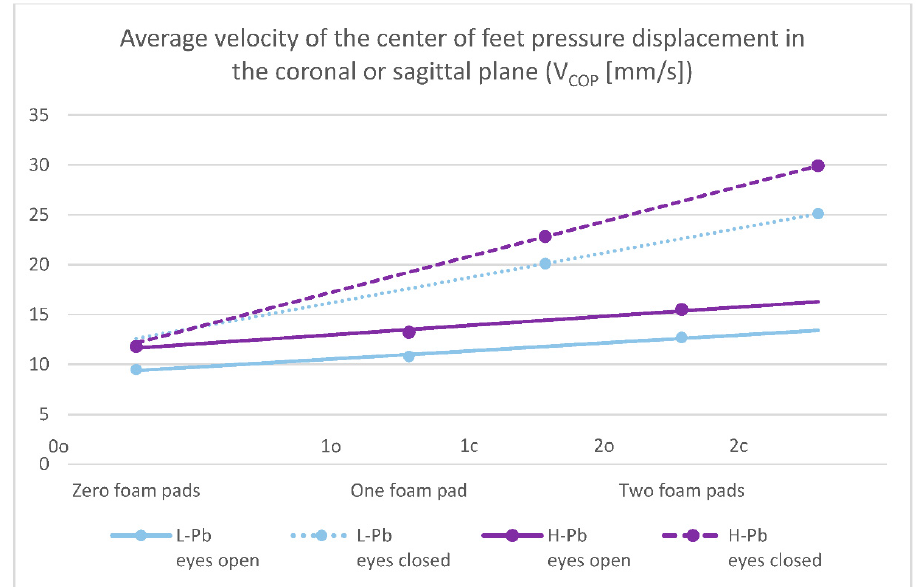
Figure 2. Posturography test results: average velocity of the center of feet pressure displacement in the coronal or sagittal plane—V COP (mm/s). L-Pb—low-PbB-level subgroup, H-Pb—high-PbB-level subgroup. Posturographic parameters are described in Table 7. A trend line has been marked. Calculations based on the values in Table 3. The graph shows only statistically significant results ( p < 0.05).